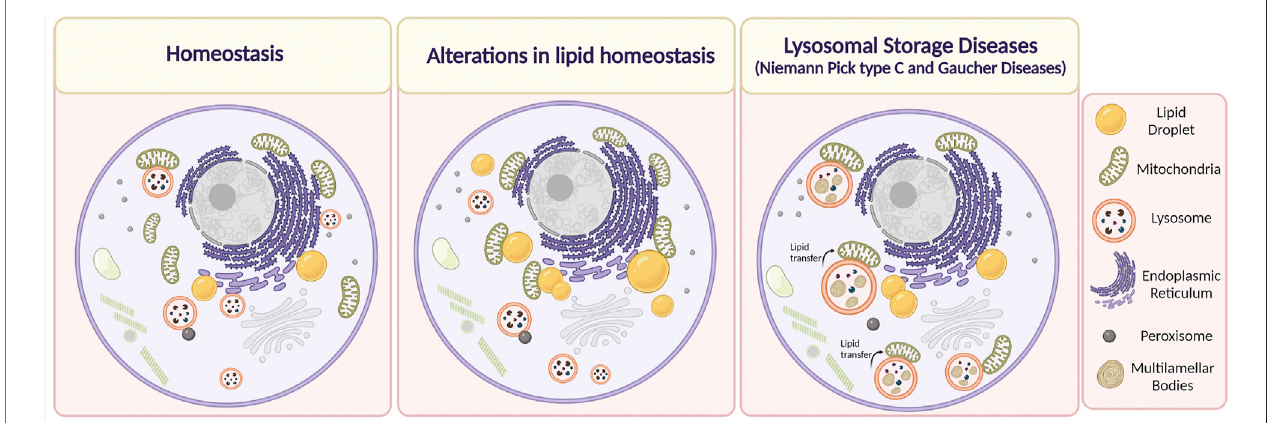
FIGURE 3 | Alterations in Membrane Contact Sites (MCSs) in lipid-related disorders. Under physiological conditions, the organelles are in close contact with each otherdependingoncellrequirements.Ithasbeendescribedthatalterationinlipidhomeostasis,suchasinthecaseofobesity,dyslipidemias,oraftertheadministrationof a high-fat diet induce an increase in MCSs between mitochondria and lipid droplets, and mitochondria and the endoplasmic reticulum. On the other hand, it has been reported that in Niemann Pick type C disease, lysosome-mitochondria MCSs increase, whereas, in the case of Gaucher disease, the duration of these contacts is higher. We speculate that there is an increase in the transfer of lipids between lysosome and mitochondria through MCSs that contributes to mitochondrial damage in NPC and Gaucher cells. Lipids are accumulated inside endolysosomes, in membrane reservoirs (Multilamellar bodies) (Created with BioRender.com).